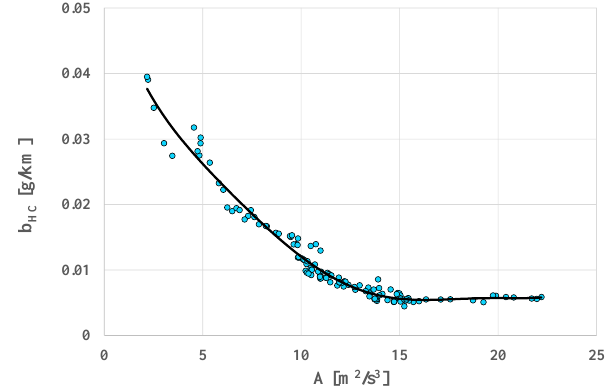
Fig. 19. Dependence of the average specific distance emission of hydro- carbons on the average value of the absolute value of the product of vehi- cle velocity and acceleration in the Malta test